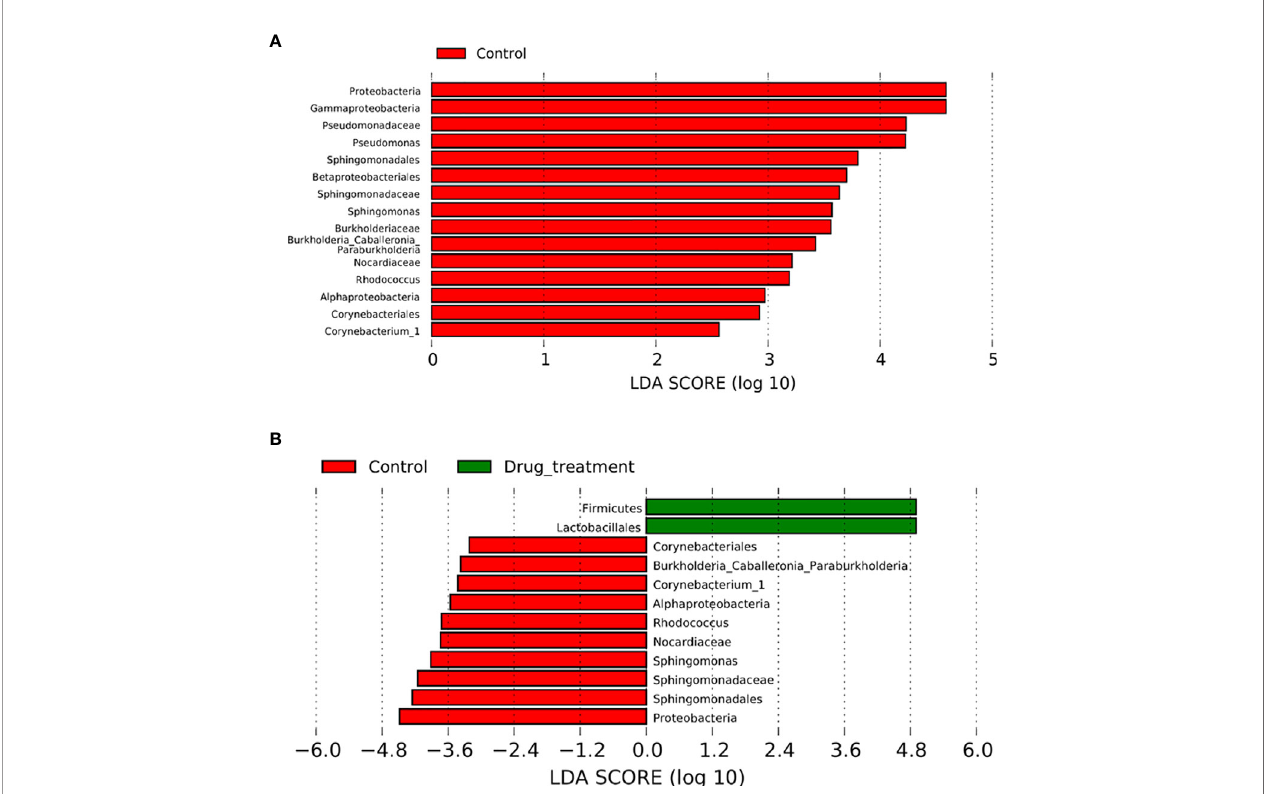
FIGURE 3 | Comparison between patients with recurrent spontaneous abortion (RSA) and controls. The effect size for each differentially abundant taxon was computed using linear discriminant analysis (LDA), which indicated its contribution to group differentiation. OTUs are presented in red and green when the taxa were signi fi cantly more abundant in the controls and RSA, respectively. (A) Differentially abundant vaginal taxa detected in patients not taking any medicine and controls. (B) Differentially abundant taxa detected in patients who did take medicine and